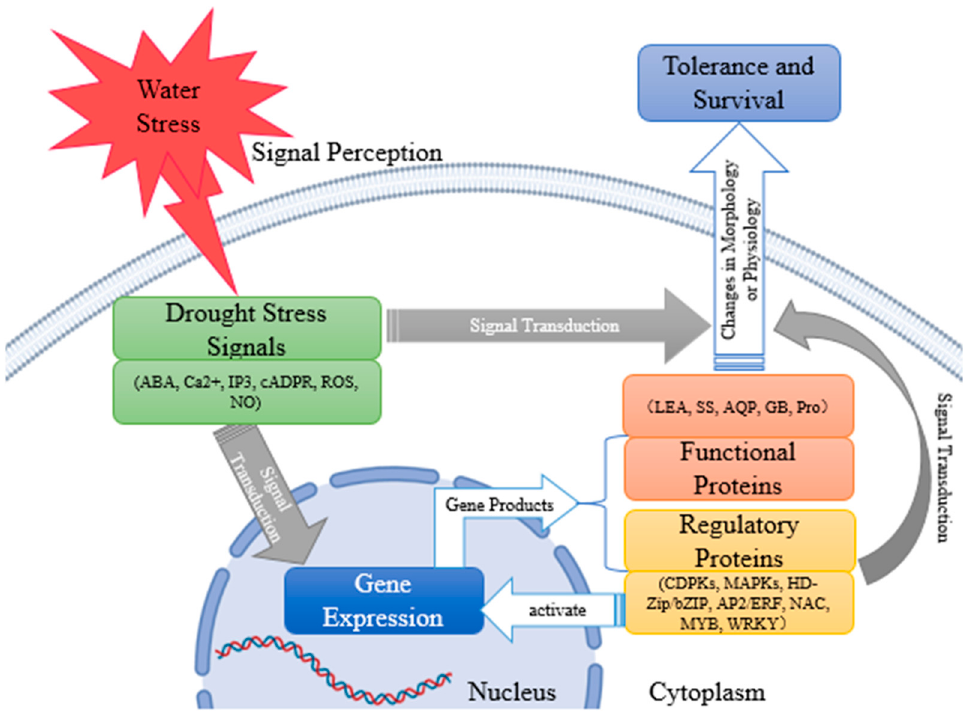
Figure 1. The process of plant drought-tolerance development.